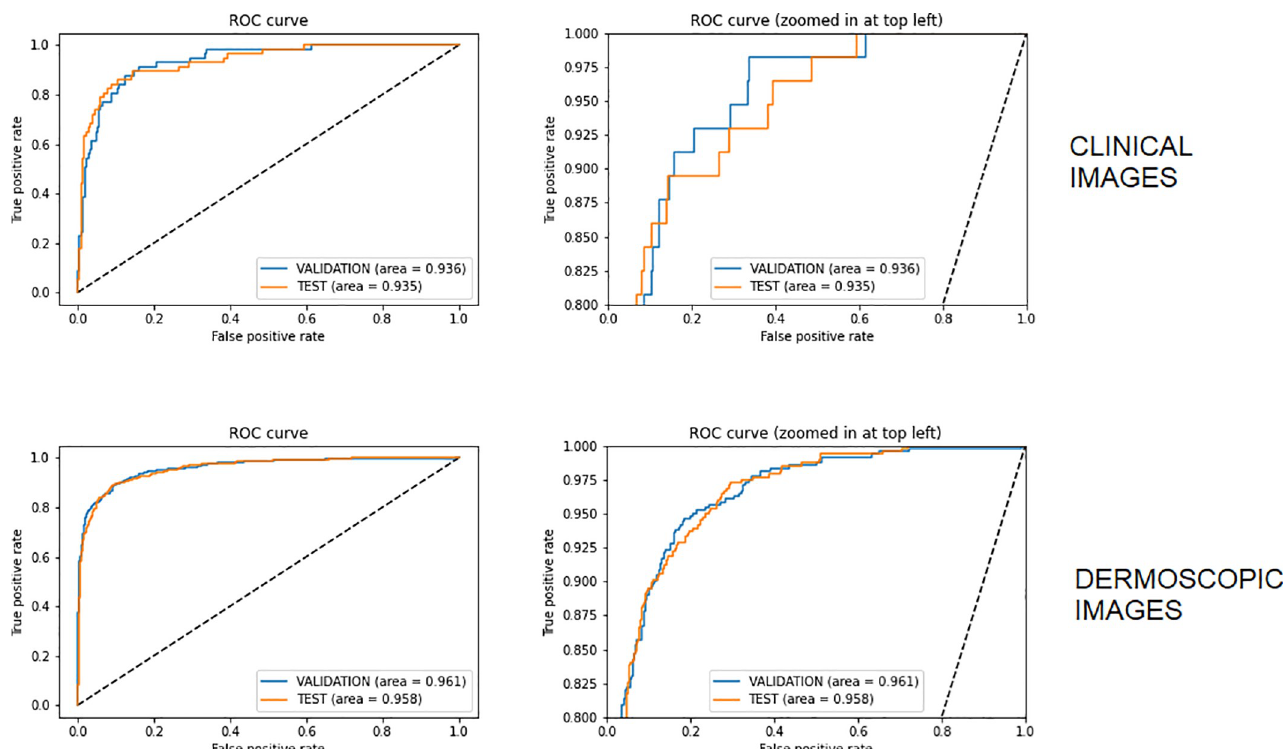
Fig 4. Receiver Operating Characteristic Curve (ROC) for clinical and dermoscopic images algorithms. Graphics on the right represent the same curves as the left, with zoomed in at the top left.